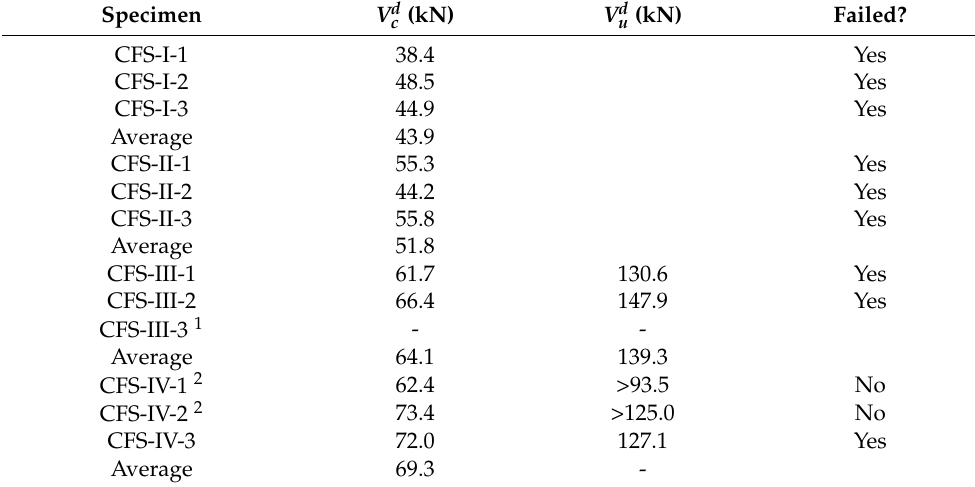
Table 4. Results of CDS test.